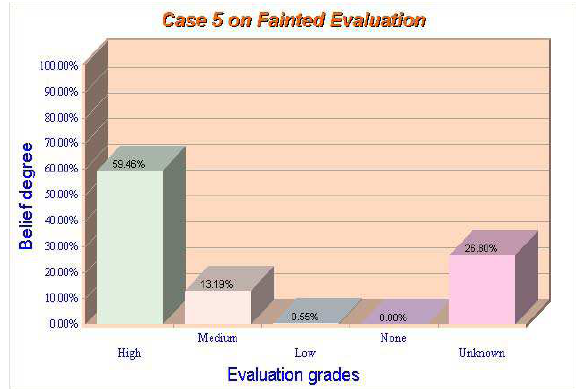
Fig. 5. Belief distribution for at kitchen on (H), tdRk (H), at reception off